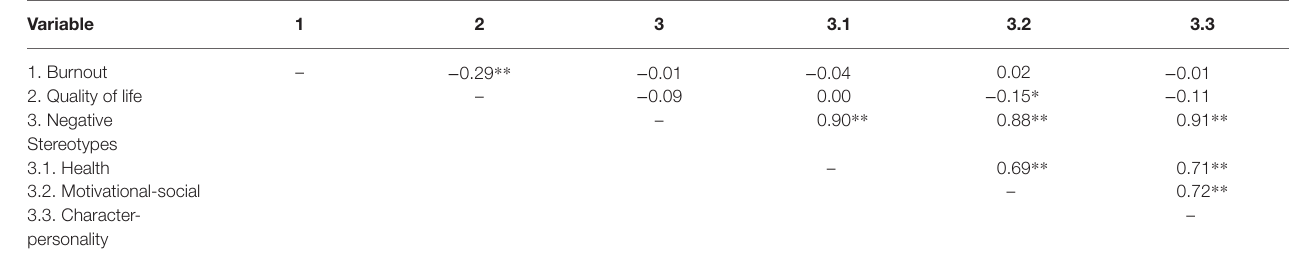
TABLE 1 | Pearson correlation coefficients, descriptive analysis, and reliability of the variables.